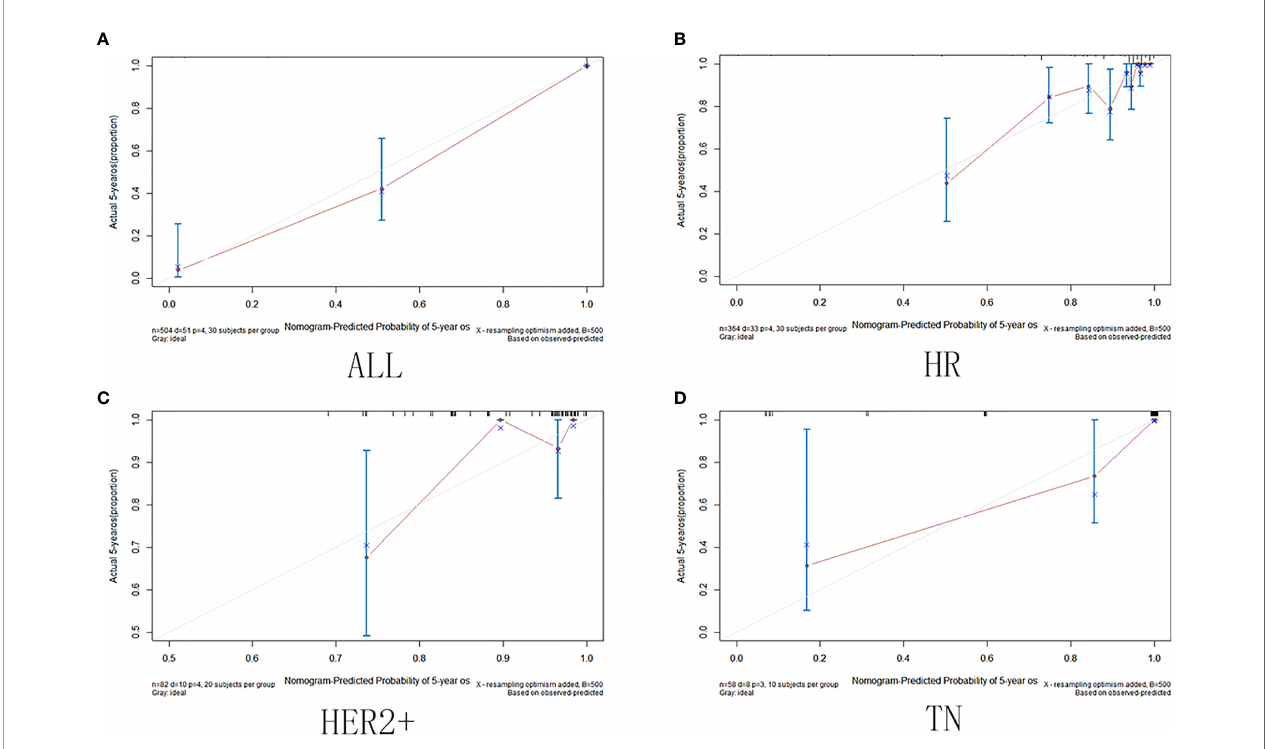
FIGURE 6 | Training set calibration curve. (A) Among all cases in the training set; (B) in HR group; (C) in HER2+ group; (D) in TN